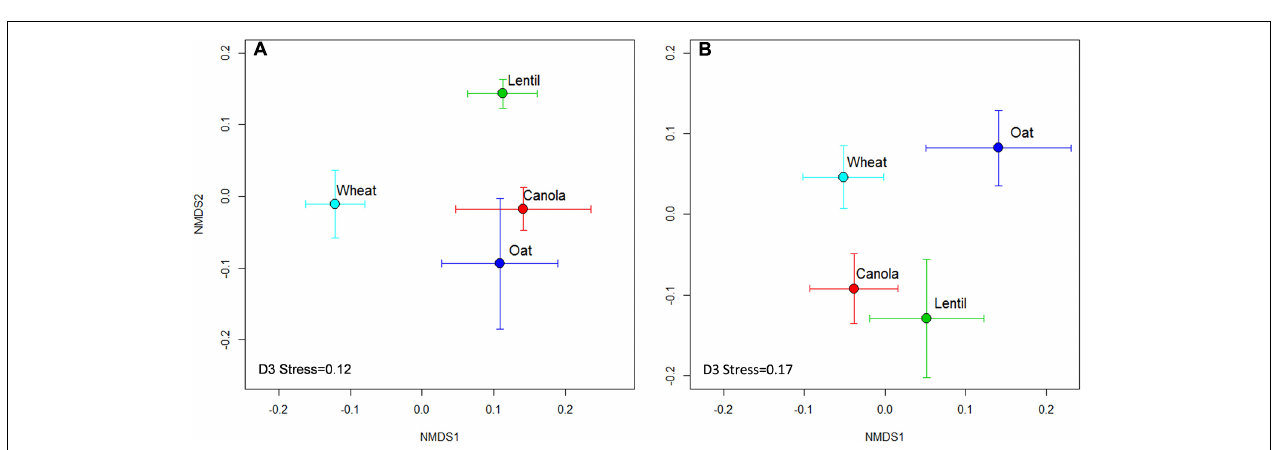
FIGURE 5 | Non-metric multidimensional scaling (NMDS) ordination of rotations on rhizosphere fungal communities in 2015 (A) and 2016 (B) . Symbols indicate the mean axis coordinates ( ± SE) for each cropping system. A significant ( P < 0.001) year effect was observed for fungal community composition and thus the year 2015 and 2016 were presented separately.